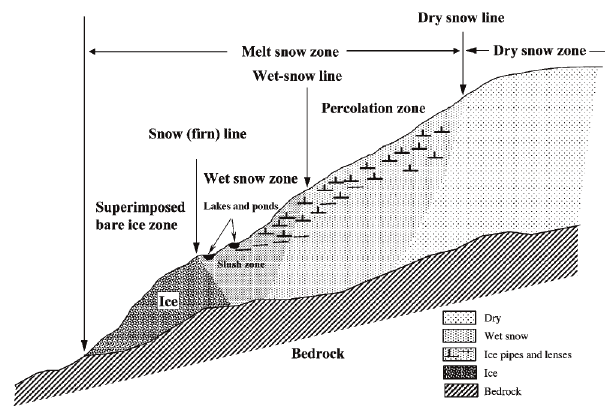
Figure 1. Schematic representation of different snow zones, from Lui et al., 2006